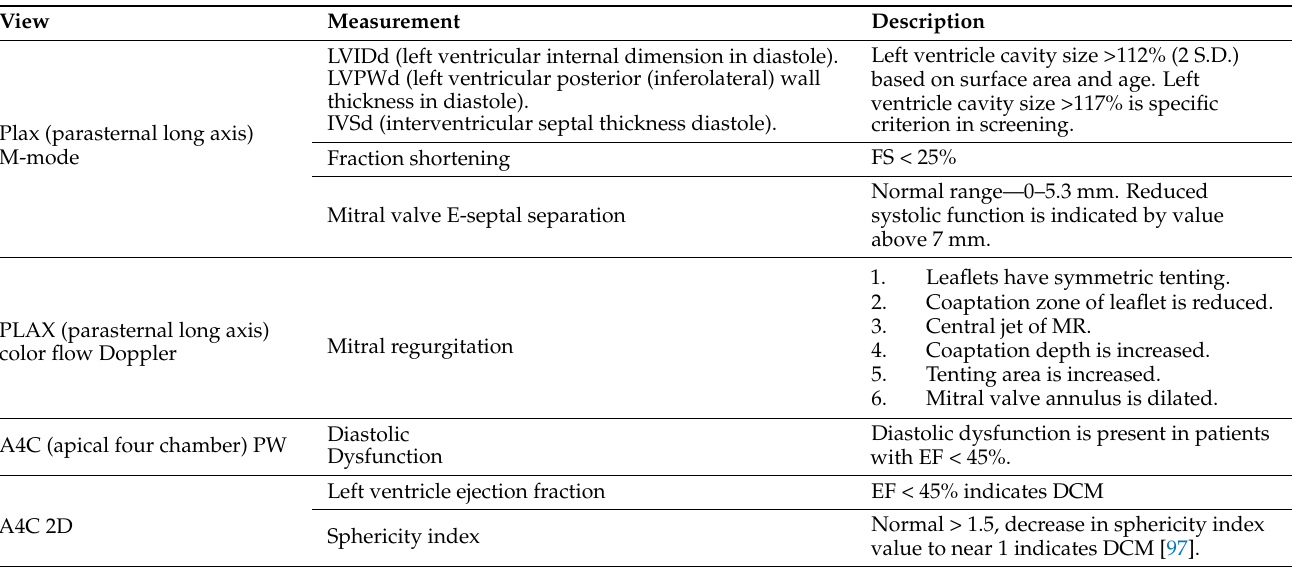
Table 3. Echocardiographic diagnosis of dilated cardiomyopathy [Adapted with permission from Mathew et al.]